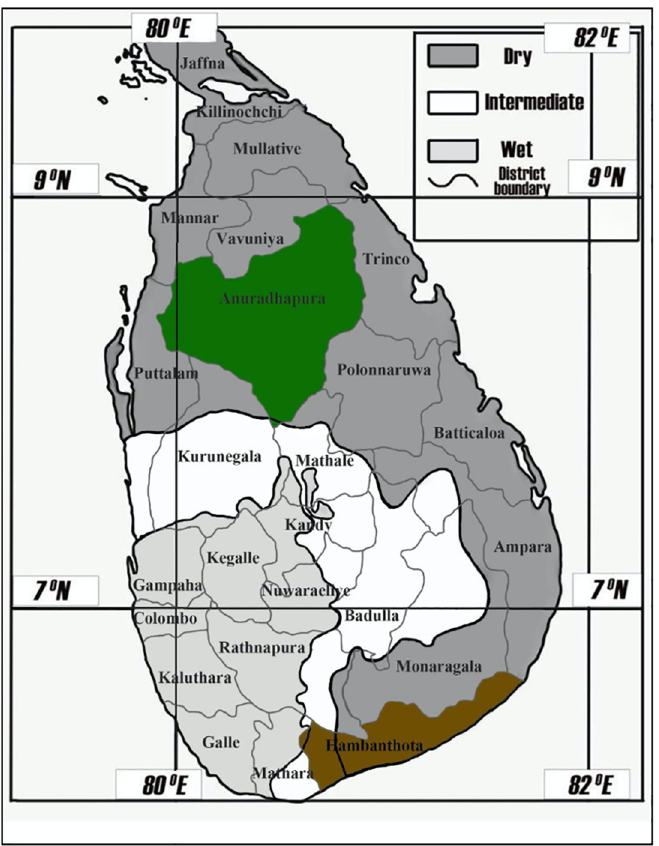
Fig 1. Three climate zones and the districts of Sri Lanka. Green: study setting; Anuradhapura district; Brown: Hambanthota district.